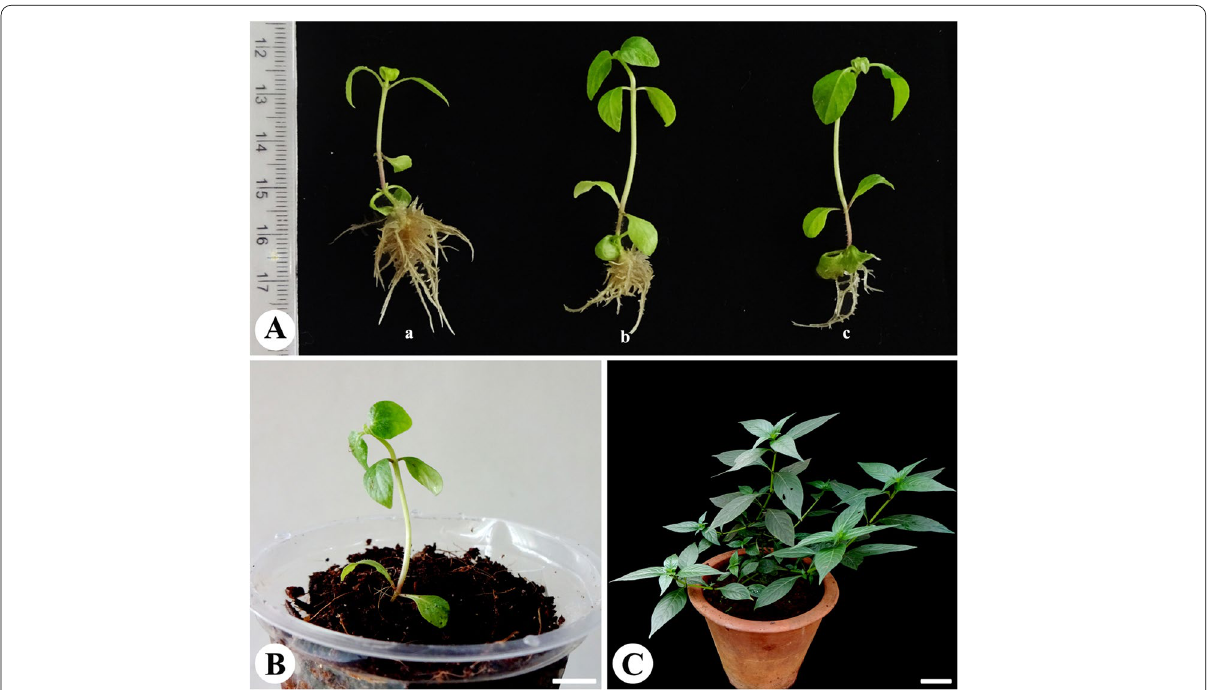
Fig. 3 In vitro rooting of shoots and acclimatization of regenerated plants of Andrographis producta . A Induction of roots from shoots on quarter strength MS medium supplemented with 10 μM IBA (a), 5 μM IBA (b), and 1 μM IBA (c). B Acclimatization of regenerated plantlets in plastic cups containing soil and cocopeat (bar-, 0.85 cm). C Three- months -old greenhouse-grown plants in the pot containing soil, sand, and farmyard manure (bar-, 5.25